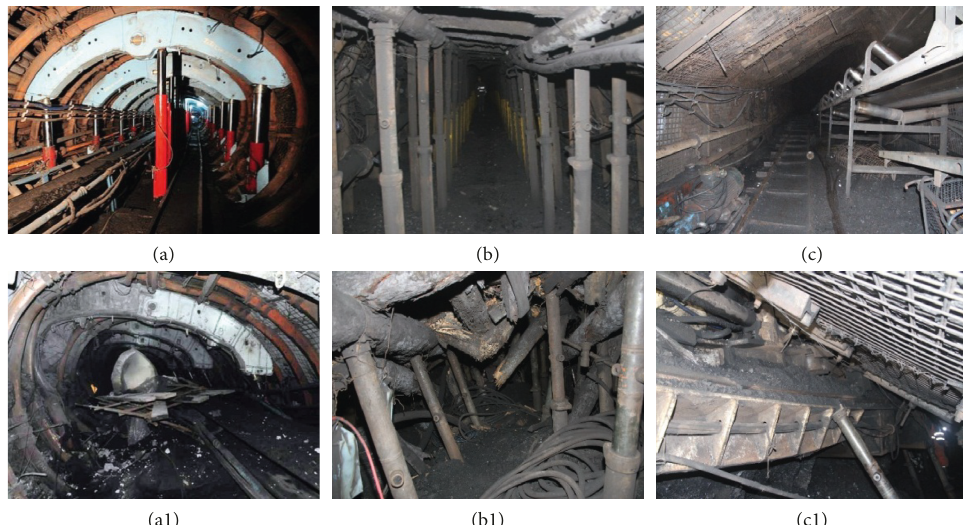
Figure 1: Photos in Yuejin (a, a1), Xing’an (b, b1), and Junde (c, c1) coal mines before (upper row) and after (lower row)